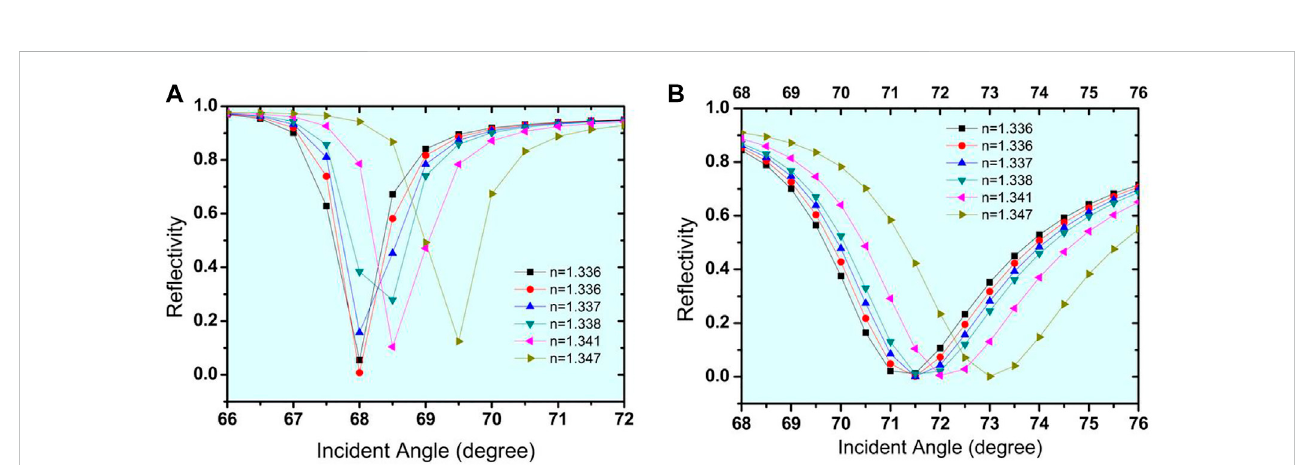
FIGURE 3 Re fl ectivitycurvewith respect tochange inincident anglefor thedetection ofurine glucose inbio-sample (A) .AgbasedconventionalSPRbiosensor (B) . Au based conventional SPR biosensor.